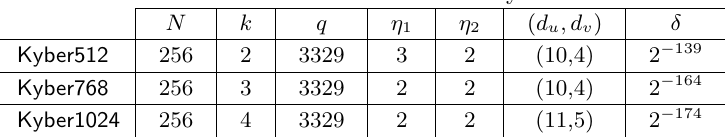
Table 6: Parameter sets for